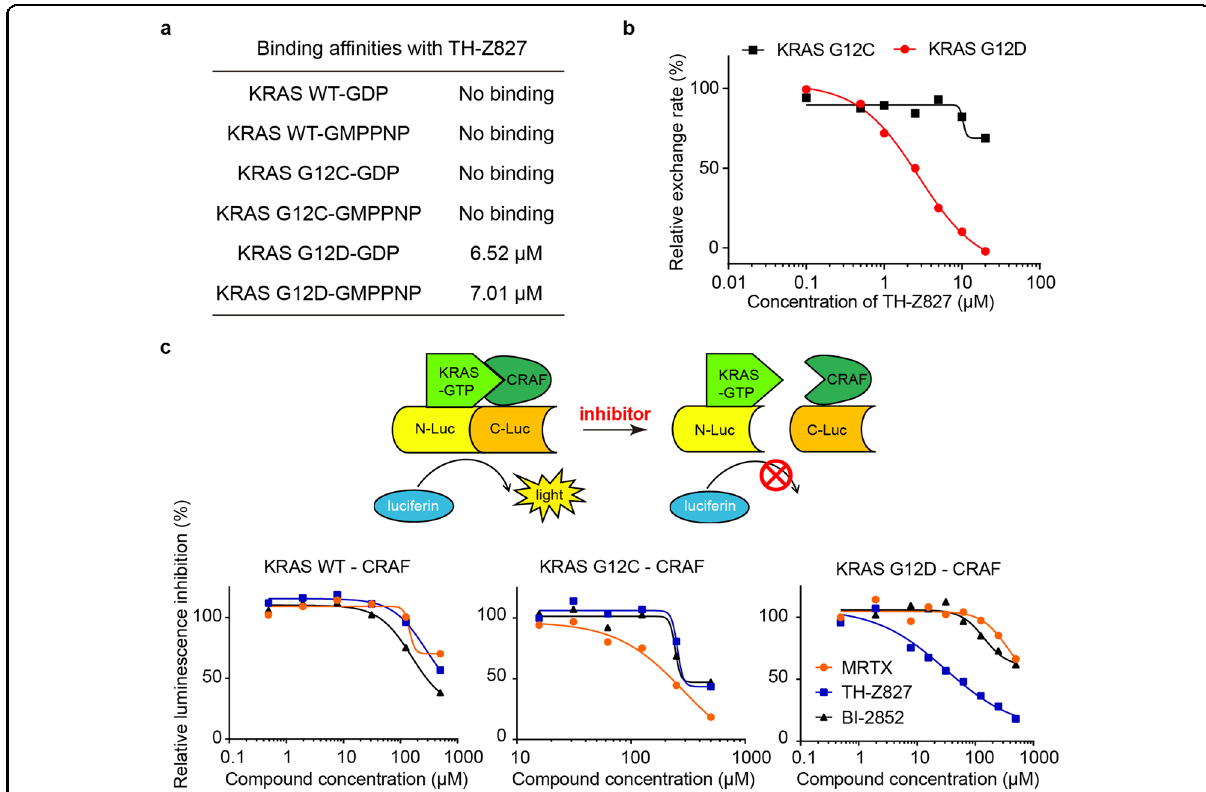
Fig. 4 Mutant-selectivity of the KRAS(G12D) inhibitor TH-Z827. a Binding af fi nities between TH-Z827 and GDP- or GMPPNP-bound KRAS (WT, G12C, or G12D). b SOS-catalyzed KRAS(G12C) or KRAS(G12D) nucleotide exchange assays in the presence of TH-Z827. c Principle of the split-luciferase reporter assay that detects the KRAS – CRAF interaction in lysates from HEK 293T cells, with or without TH-Z827. Two other compounds (the G12C inhibitor MRTX and the pan-RAS inhibitor BI-2852) were included as